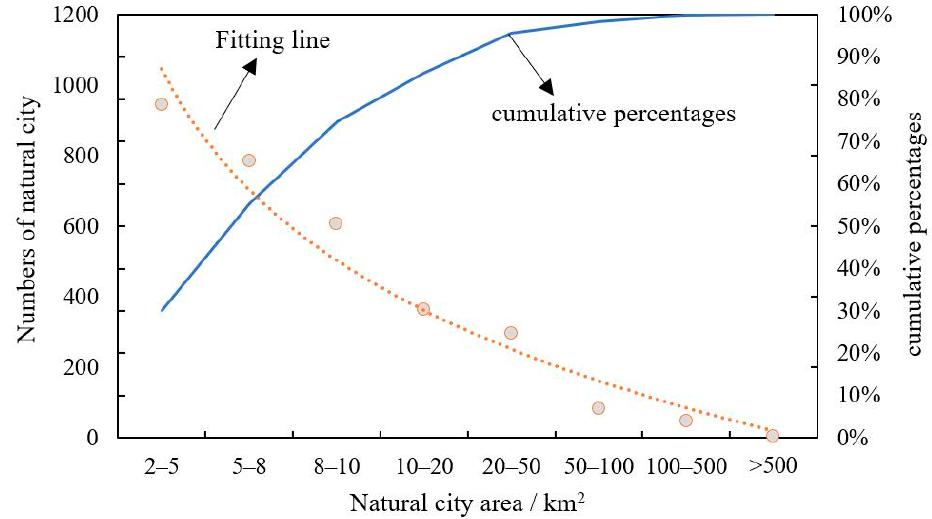
Figure 5. Relationship between natural city areas and the numbers of natural cities.